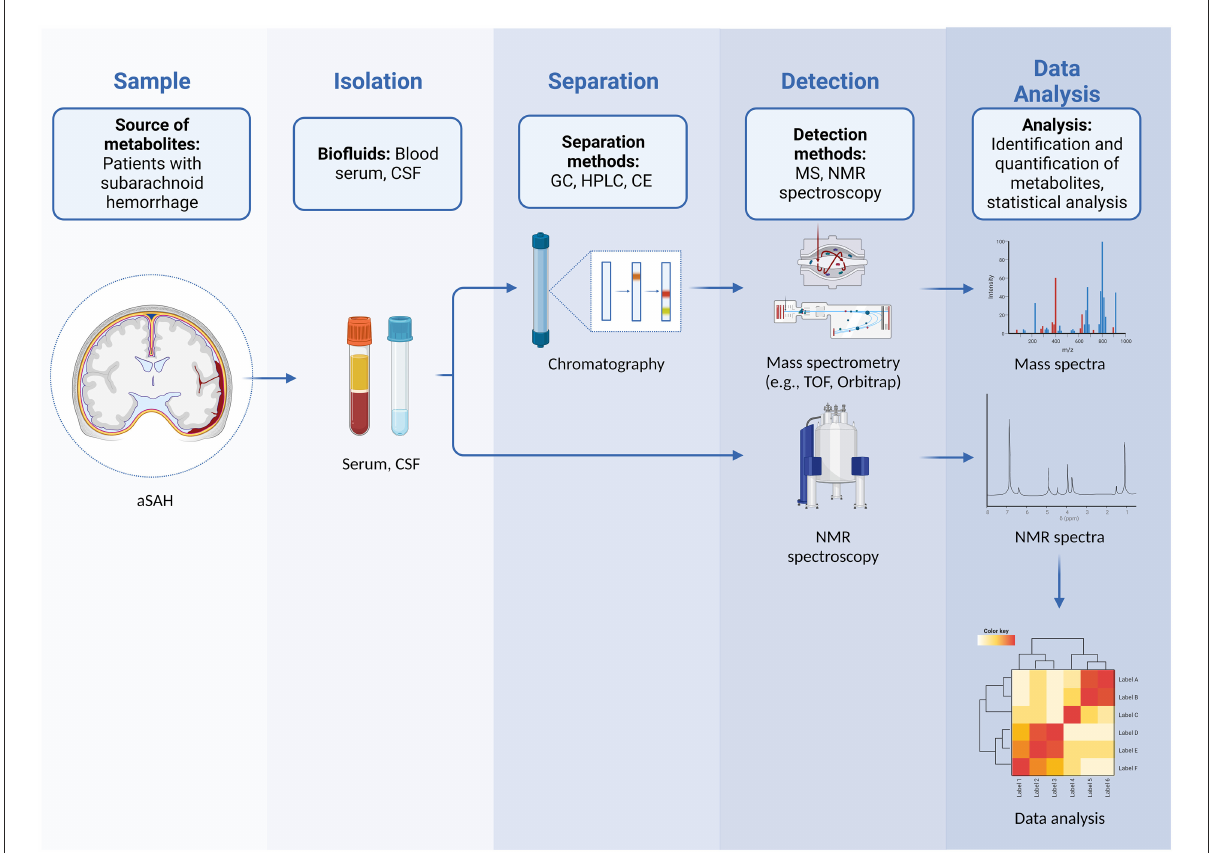
FIGURE1 Workflow in untargeted metabolomics in patients with aSAH showing steps that include sampling and isolation of biological fluids, separation, detection of metabolites, and subsequent data analysis with identification and quantification of